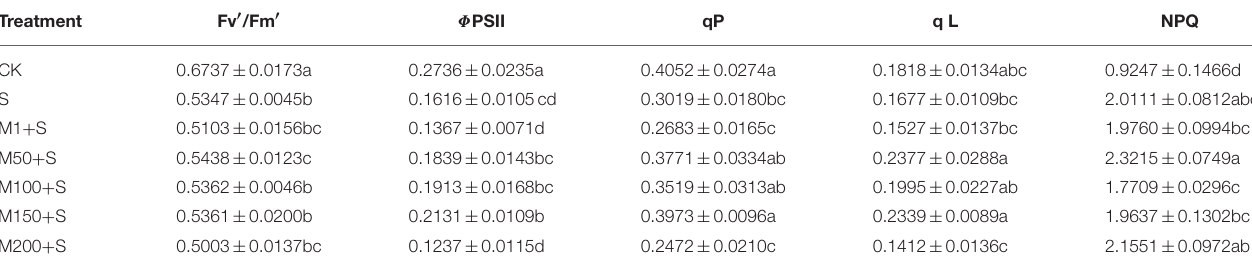
TABLE 1 | Effects of NaCl with and without melatonin on chlorophyll fluorescence parameters in tomato seedlings. Treatment Fv ′ /Fm ′